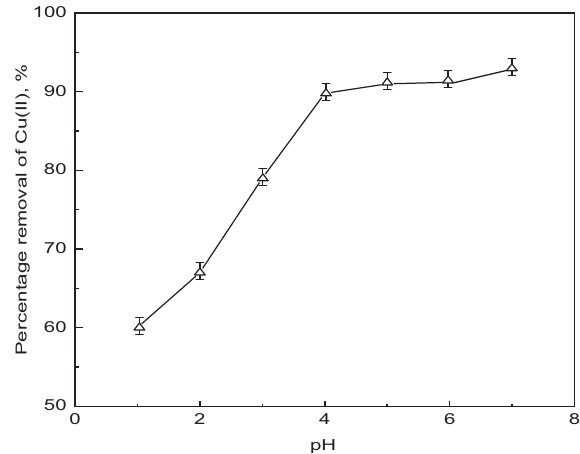
Figure 3. Variation of pH on the Cu(II) adsorption: Initial Cu(II) concentration: 25 mg/L; Adsorbent dose: 10 g/L; Contact time: 5 h